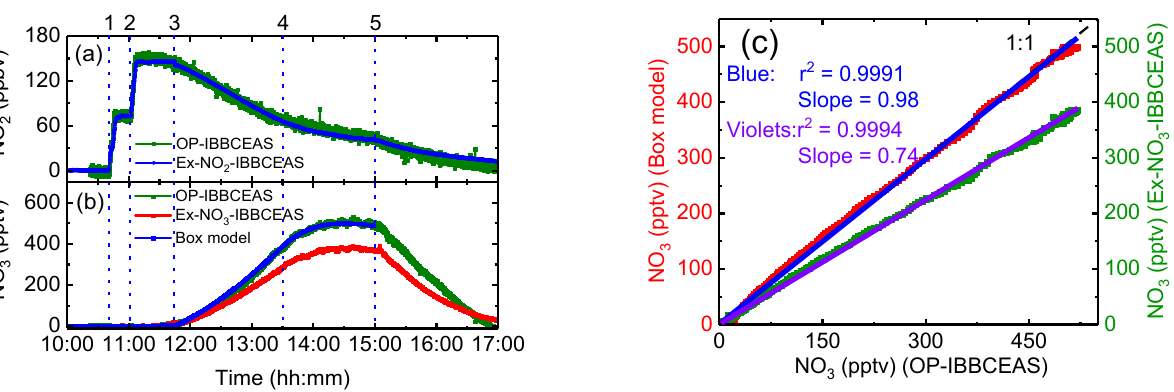
Figure 6. Time-series measurement of NO 2 , NO 3 concentrations and the NO 3 box model simulation results. ( a ) Time series of NO 2 concentrations retrived by OP-IBBCEAS (green data) and extractive NO 2 -IBBCEAS (blue data). ( b ) Time series of NO 3 concentrations retrived by OP-IBBCEAS (green data), extractive NO 3 ‐ IBBCEAS (red data), and a box model simulation curve (blue data). The SAES ‐ ARC experiment event sequence was: (1) 10:48, 75 ppbv of NO 2 added, fan on; (2) 11:02, 75 ppbv of NO 2 added; (3)–(4) 11:40–13:30, 130 ppbv O 3 added; (4) 13:30: fan off; (5) 15:00, flush on. ( c ) Correlation of the measured NO 3 concentrations between OP ‐ IBBCEAS and box model simulation (Blue line), and extractive NO 3 ‐ IBBCEAS (Violet line).